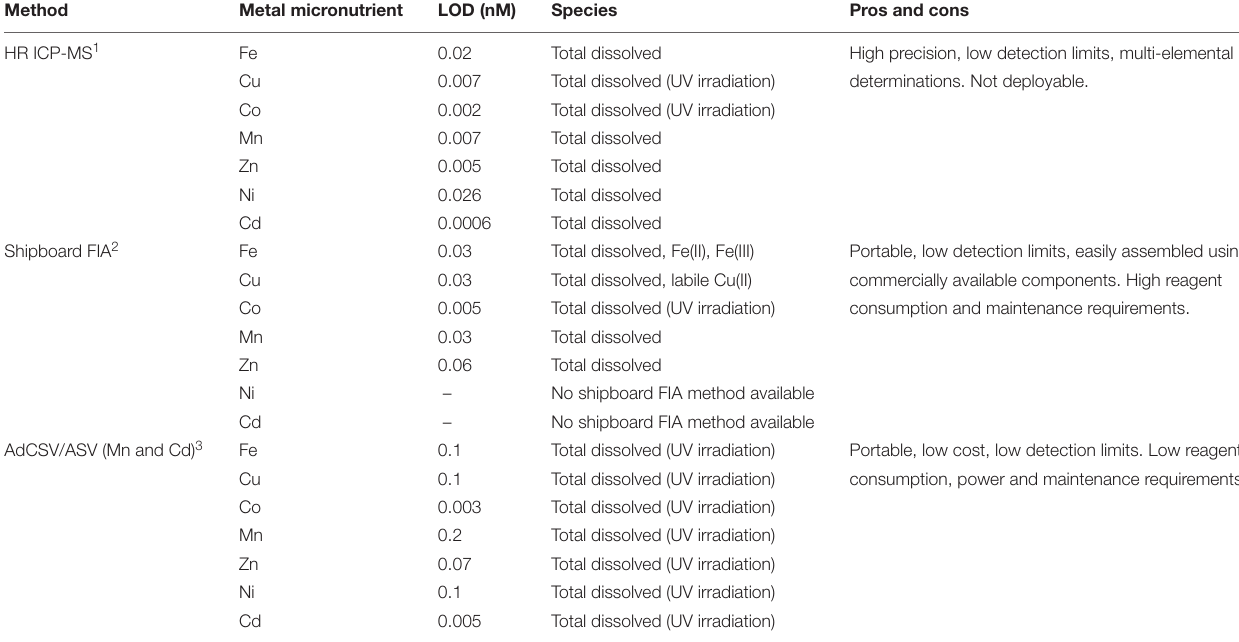
TABLE 2 | State of the art figures of merit for lab and shipboard measurements on discrete samples.